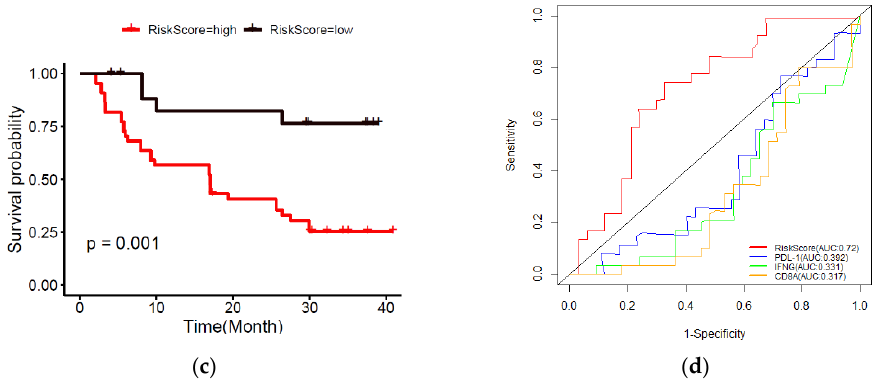
Figure 7. The risk score gene signature can predict the response of melanoma patients to anti-PDL1 therapy. ( a ) The ratio of immunotherapy responses of melanoma patients with high- or low-risk scores. Statistical significance was computed using the chi-square test; ( b ) ROC curves evaluate the accuracy of the signature for predicting the response of patients; ( c ) Kaplan–Meier curves of the overall survival of patients. Statistical significance was calculated using the log-rank test; ( d ) ROC curves of the sensitivity and specificity of the signature compared with other biomarkers in predicting the OS of patients in the immunotherapy dataset. CRPR, complete/partial remission; PD, progressive disease.